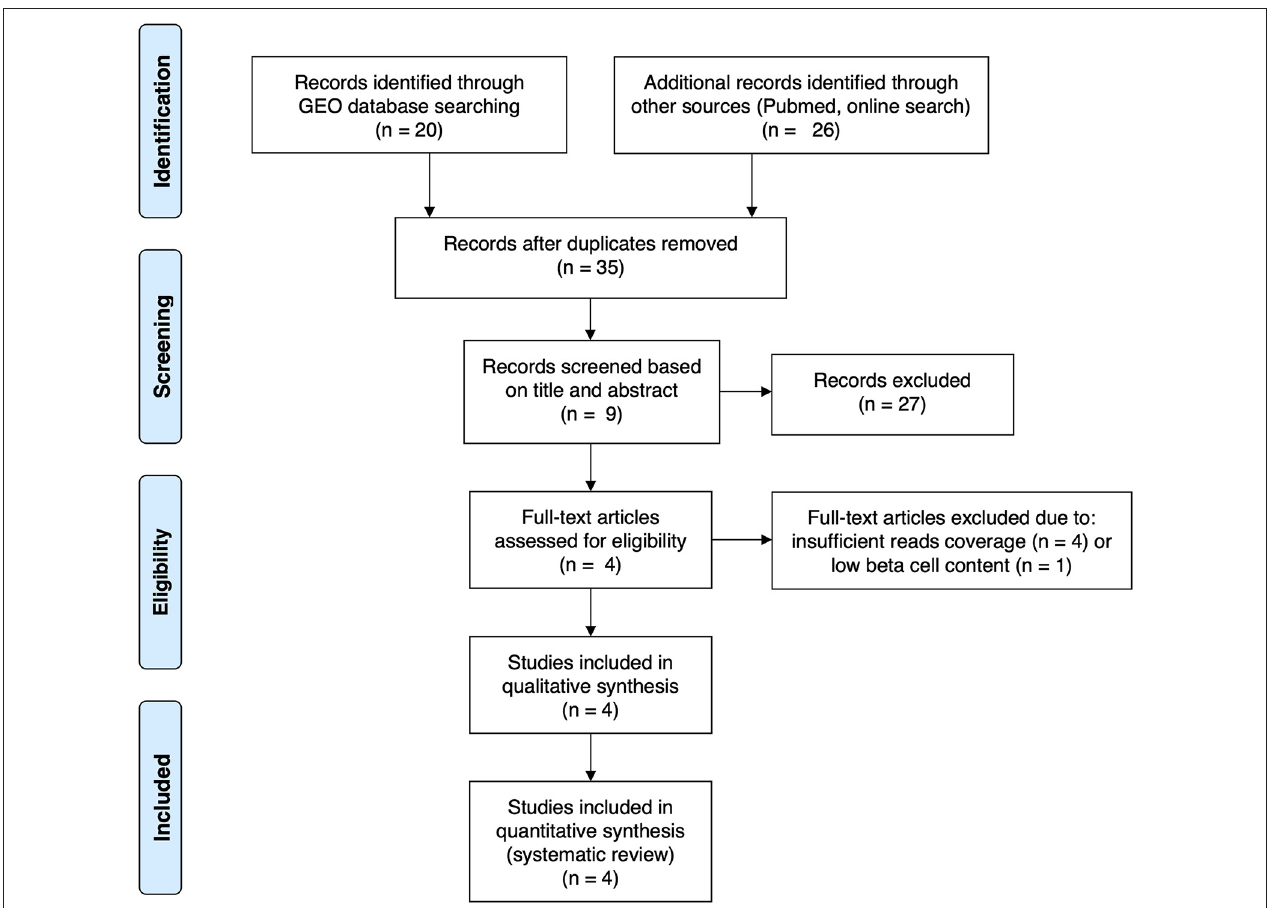
FIGURE 1 | PRISMA flow diagram (19) describing the search strategy used to identify the analyzed